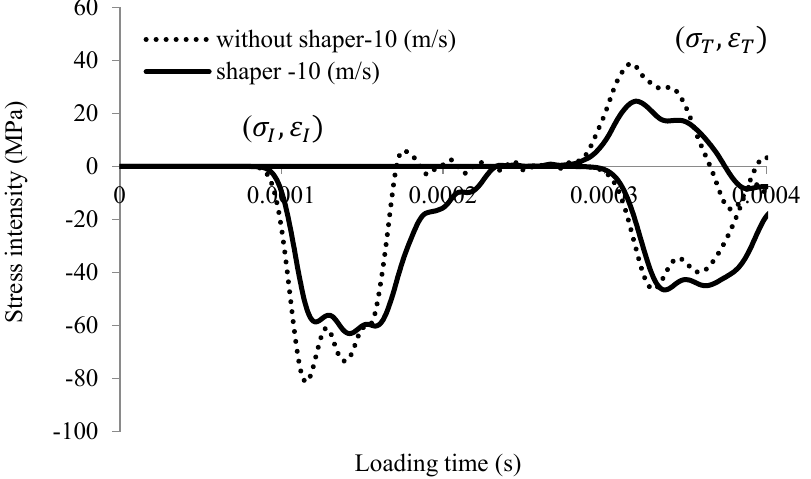
Figure 2. Elastic wave history signal using SHPB (numerical results with and without shaper) for an initial impact velocity of V 0 = 10 m/s .